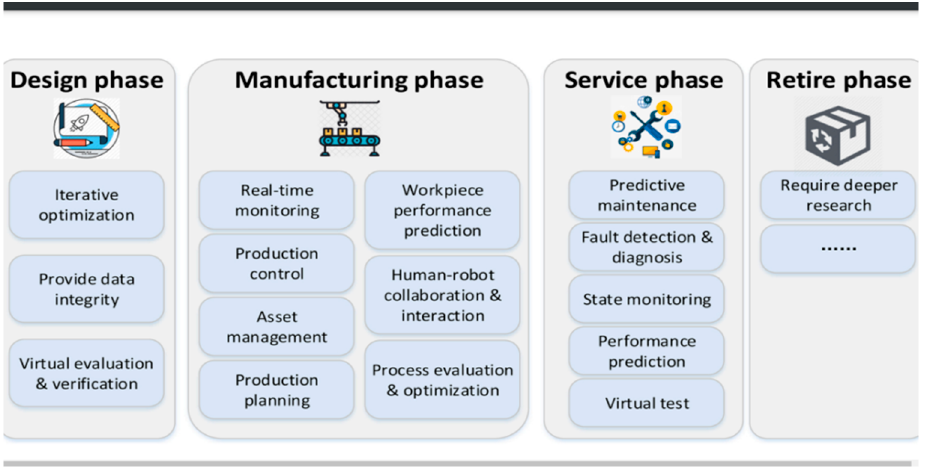
Figure 6. Applications of digital twin [42].